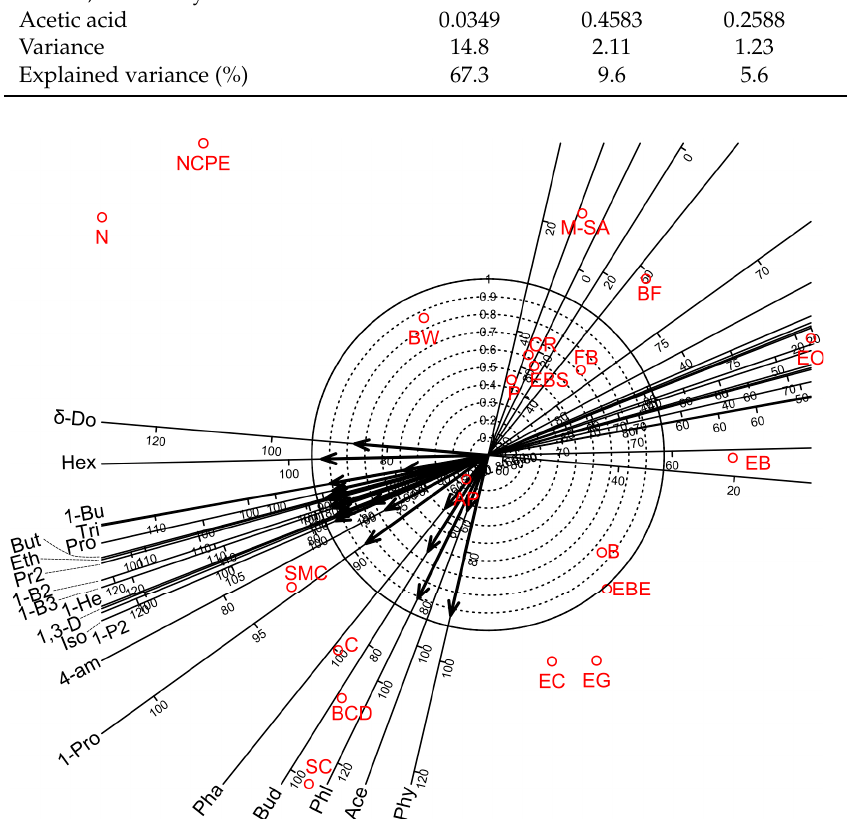
Figure 3. Biplot diagrams of Factor 1 versus Factor 2 of Principal Axis Factor Analysis (Iterated Principal Factor) conducted for twenty-two volatile organic compounds (VOCs) of white wine samples in twenty-one bentonite product treatments (Debrecen-Pallag, Hungary). Explanations for VOCs abbreviations are given in Table 12. Explanations for bentonite product name abbreviations (red colour) are given in Table 1.